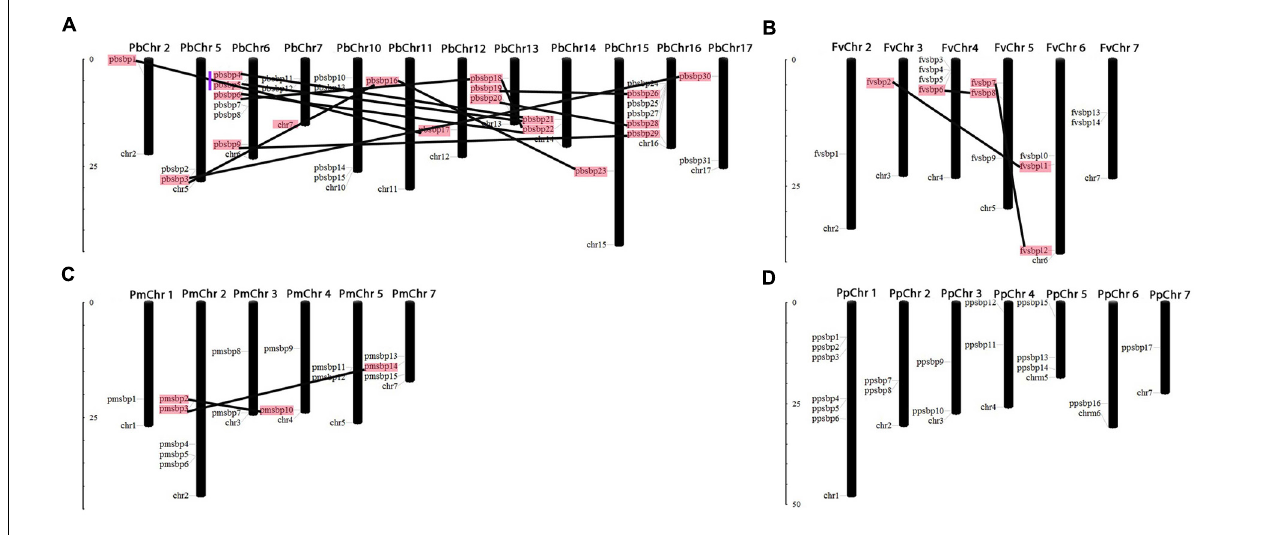
FIGURE 1 | Chromosomal locations and region duplications of the SBP-box genes in the genome of Pear (A) , Strawberry (B) , Mei (C) and Peach (D) . The chromosome number is represented at the top of each chromosome and the left scale is in megabases (Mb). The segmental duplicated genes are represented by black lines and tandemly duplicated genes by blue vertical